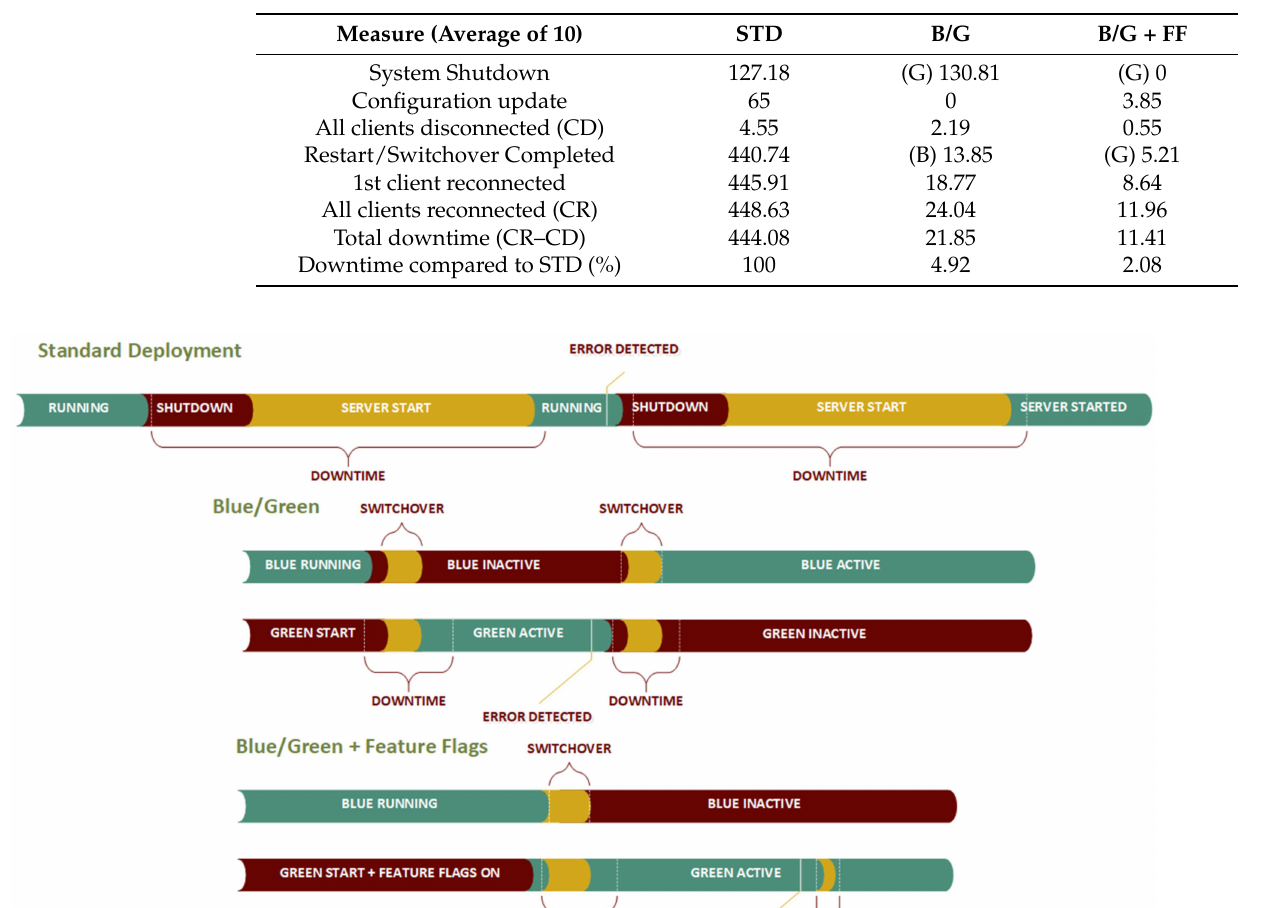
Table 2. ERP level—server node restart (roll back required, all measurements in seconds, time reference point—restart/roll back process initiated, STD—standard approach, B—blue, G—green, FF—feature flags).